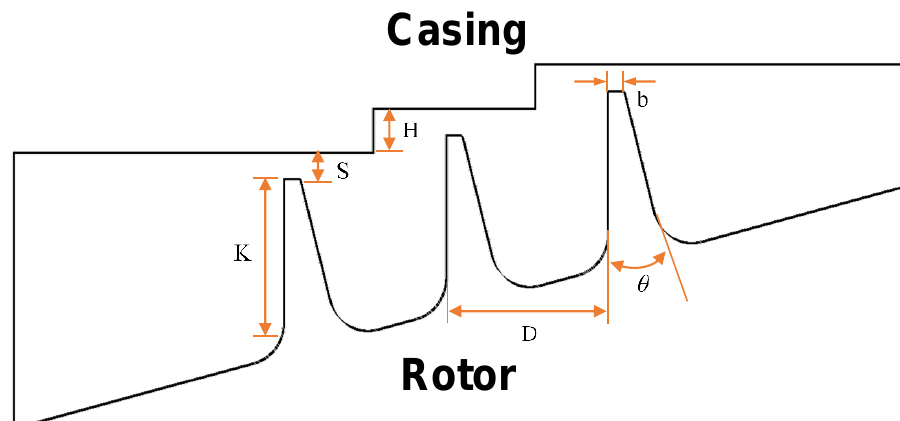
Figure 1. Schematic of the conventional stepped seal.